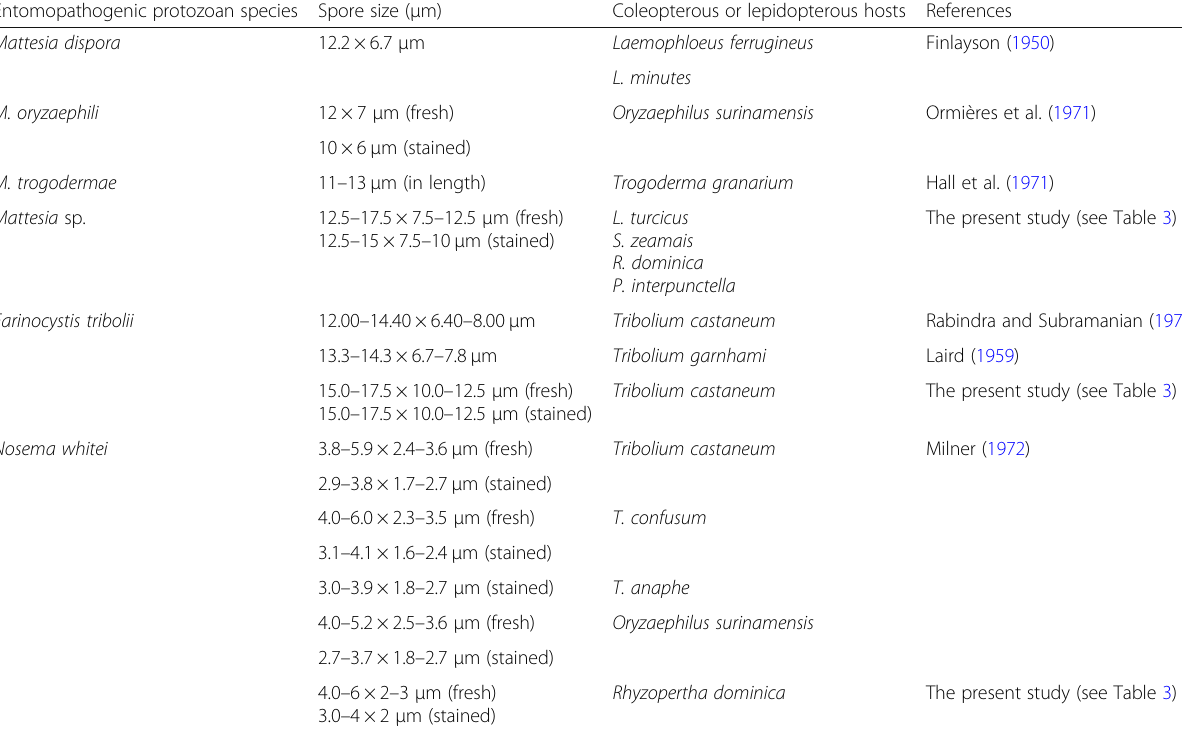
Table 4 Summary of spore sizes of Mattesia spp., Farinocystis spp., and Nosema spp. reported in literature from some coleopterous or lepidopterous stored-product hosts Entomopathogenic protozoan species Spore size ( μ m)